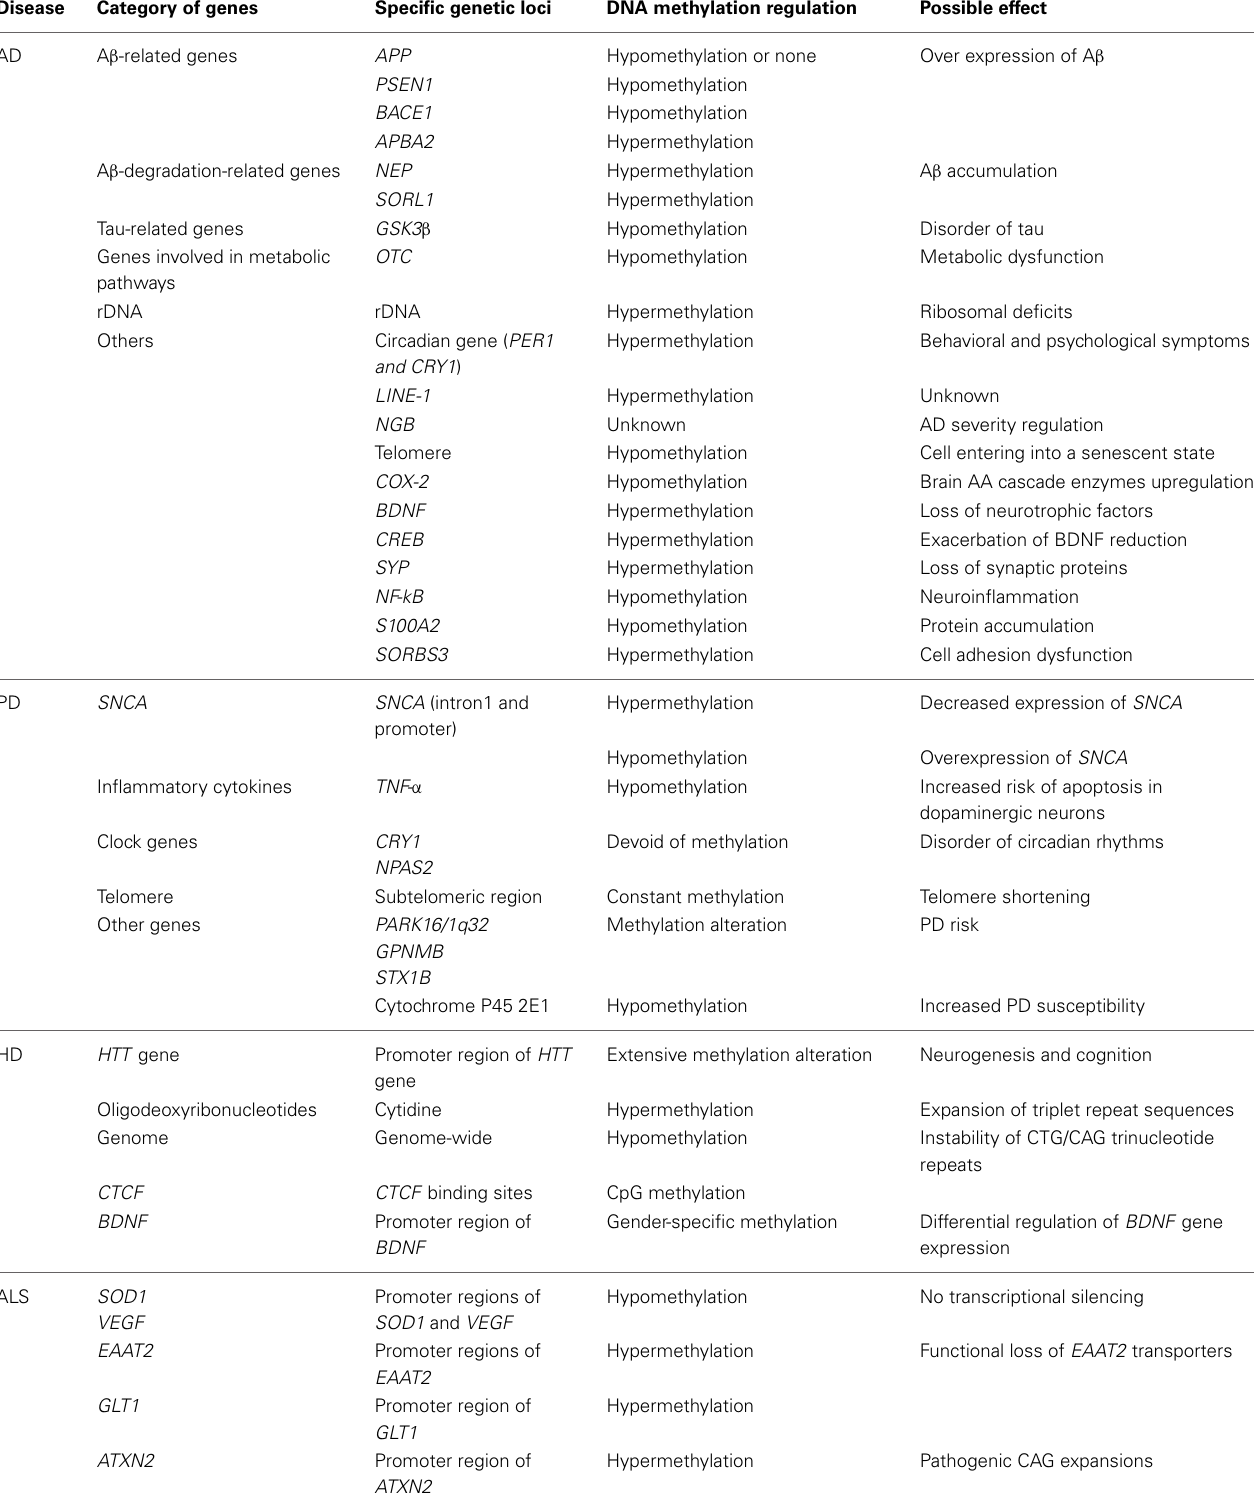
Table 1 | Altered DNA methylation profiles observed in neurodegenerative diseases.